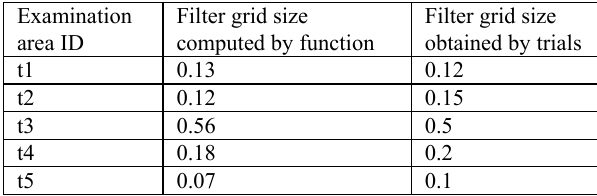
Table 2. Optimal filter grid size of each examination area (unit: